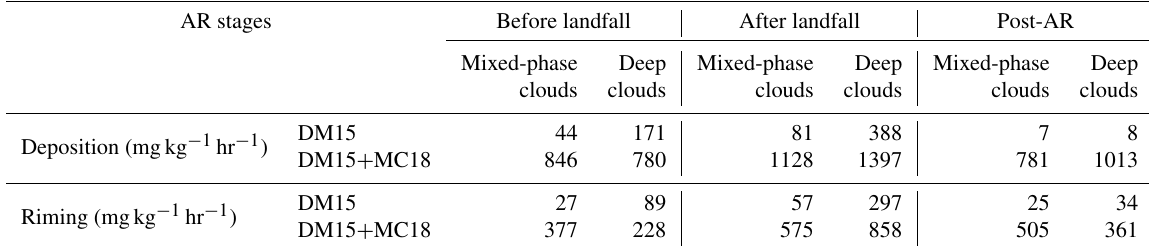
Figure 10. Time–height cross sections of (a) dust particle ( > 0 . 5µm) number concentration, (b) marine aerosol number concentration, (c) the freezing rate in DM15, and (d) the freezing rate in DM15 + MC18. The number concentrations in (a) and (b) are derived from their corresponding mass mixing ratios under the clear-sky condition only. The freezing rates in (c) and (d) are the ice nucleation rates via immersion freezing at T > − 37 ◦ C and the drop homogeneous freezing rates at T < − 37 ◦ C, and the values are for cloudy-points only. The contour black lines in each panel mark the temperature levels of − 15 and − 37 ◦ C, representing the efficient immersion freezing temperature in DM15 + MC18 and the homogeneous freezing temperature in the model, respectively. Table 2. The domain-mean mass rates of deposition and riming in the mixed-phase and deep cloud regimes in DM15 and DM15 + MC18 at the three AR